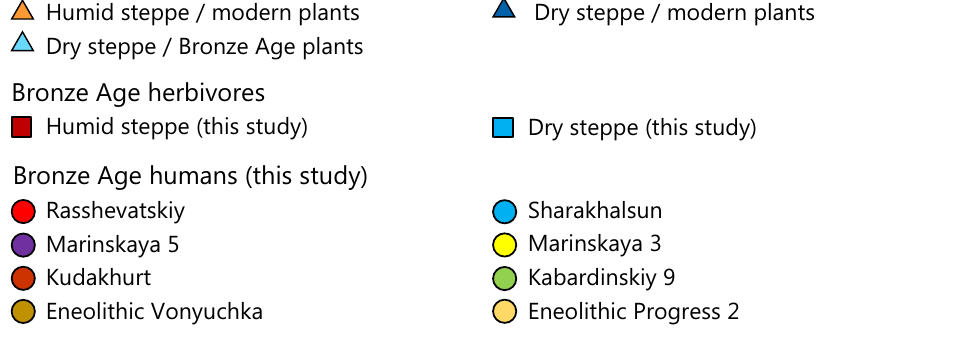
Fig 8. Medians and interquartile ranges of δ 13 C and δ 15 N values of animal bone collagen from the humid and dry steppe and humans grouped according to sites. The shaded areas indicate potential medians and interquartile ranges of herbivores feeding on modern or archaeological plants from different portions of the steppe (Plant data after: Shishlina et al.